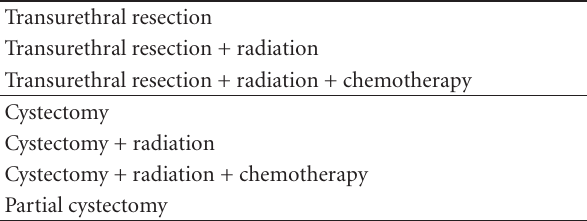
Table 1: Treatment modalities for the bladder